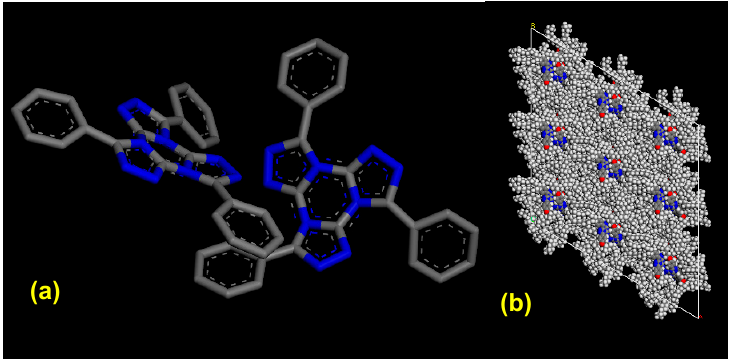
Figure 7. ( a ) Simulated structure of t -66 : aromatic part of dimer; ( b ) view on 3 × 3 × 6 unit cells.